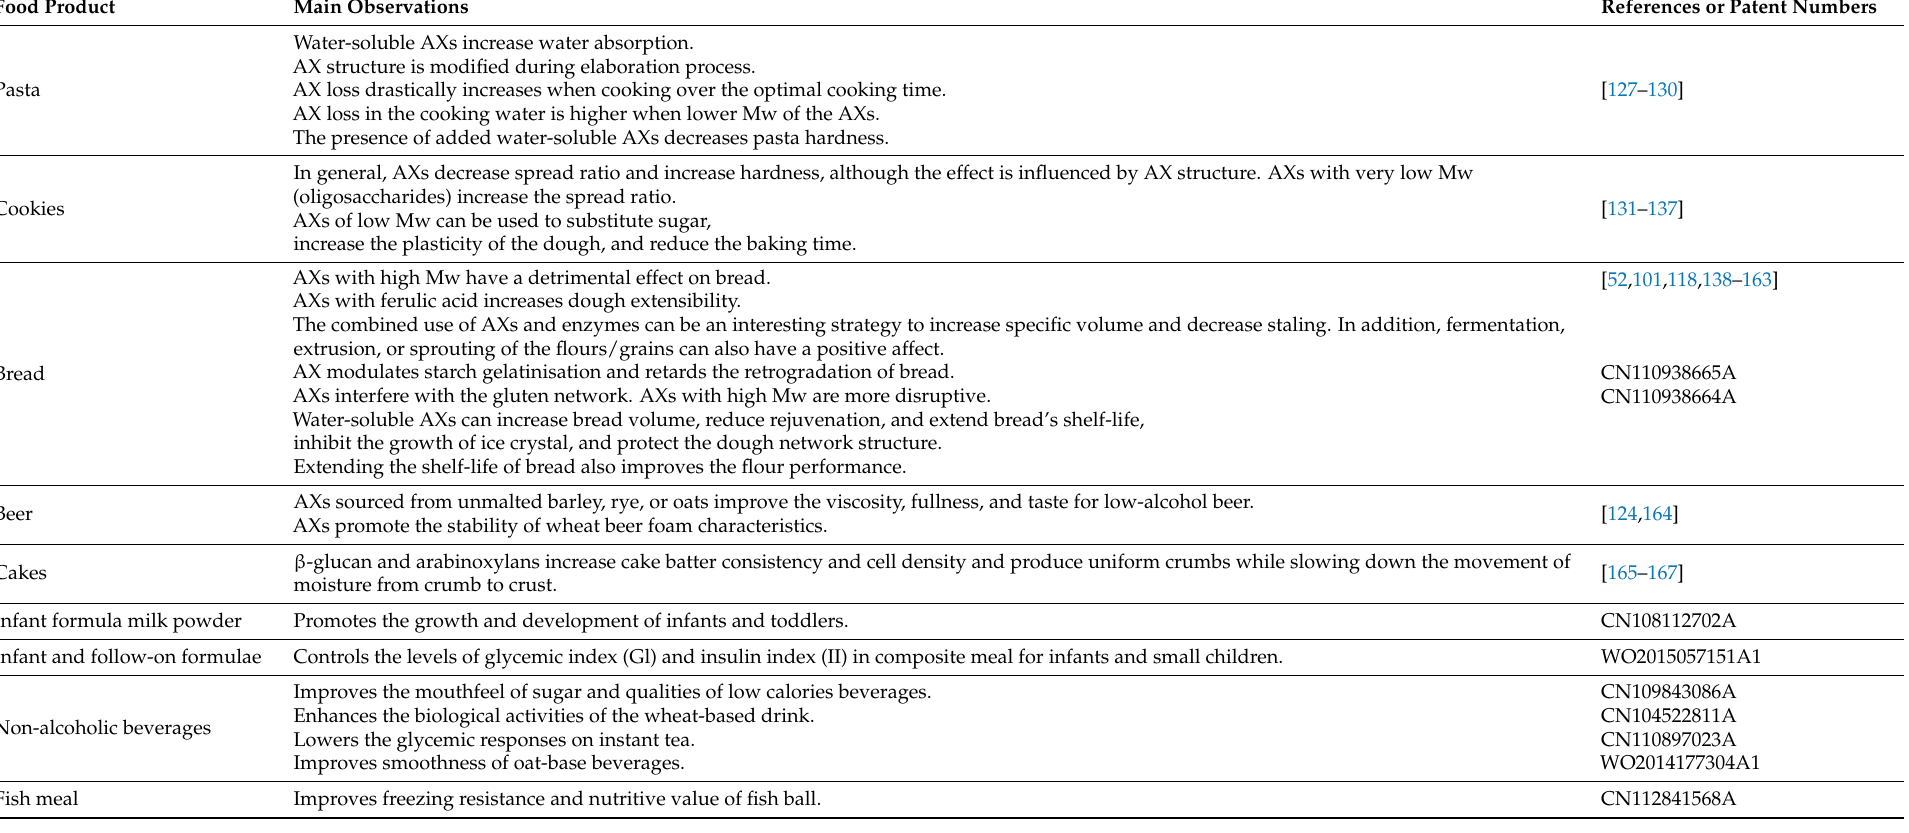
Table 4. Main AX effect on food